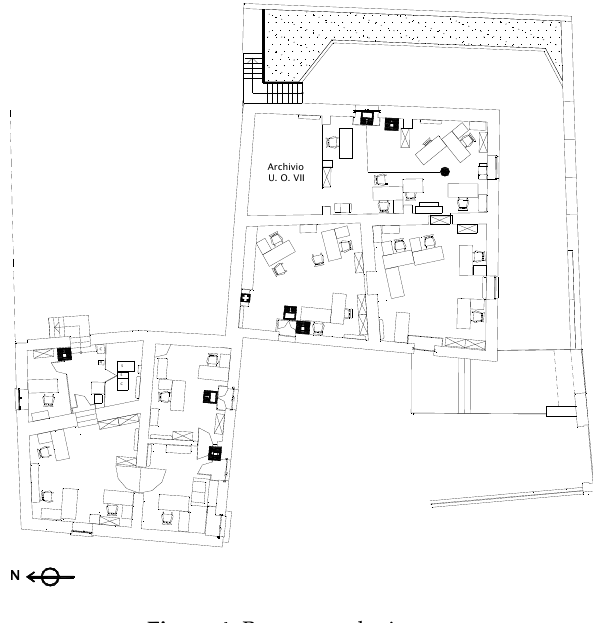
Figure 4. Basement planimetry.